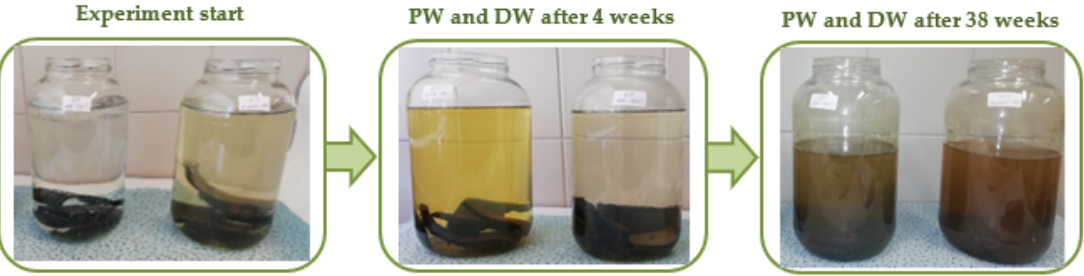
Figure 7. The course of colour changes in the experimental